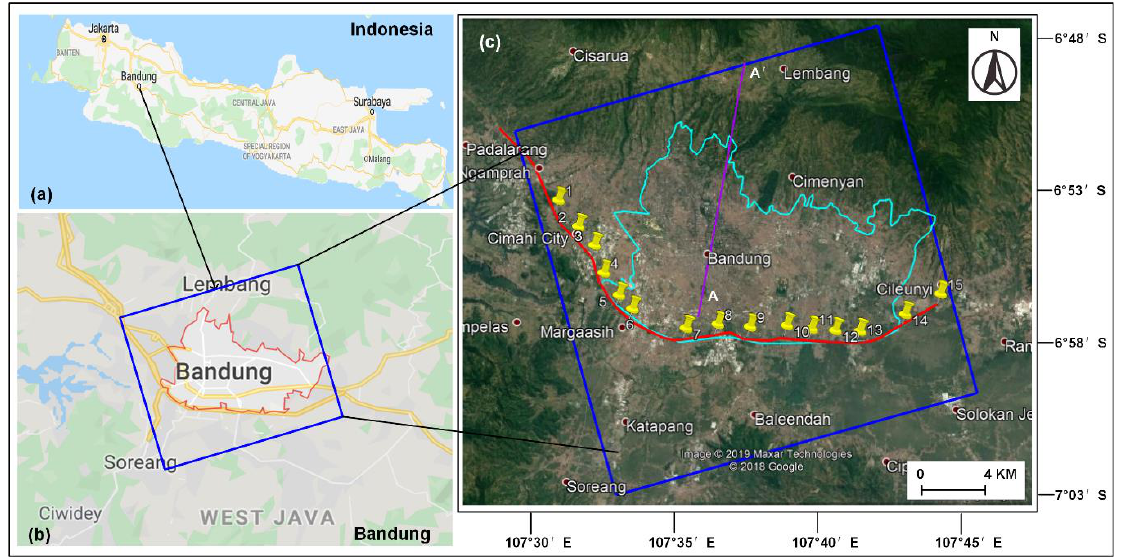
Figure 1. The geographic location of the study area and SAR datasets of Sentinel-1 data. The Spatial coverage of the study area of Sentinel-1 data is declined with a blue rectangle in ( b , c ). The red area in ( b ) and light blue area in ( c ) represents the Bandung municipality. The red line highlights part of the planned Jakarta-Bandung high-speed railway. The purple line that is named A-A’ presents the location of the aquifer profile as illustrated in Figure 2. The collected 15 leveling points along the planned railway are marked with yellow place marks. The geographical maps of ( a , b ) and the background map of ( c ) are from Google